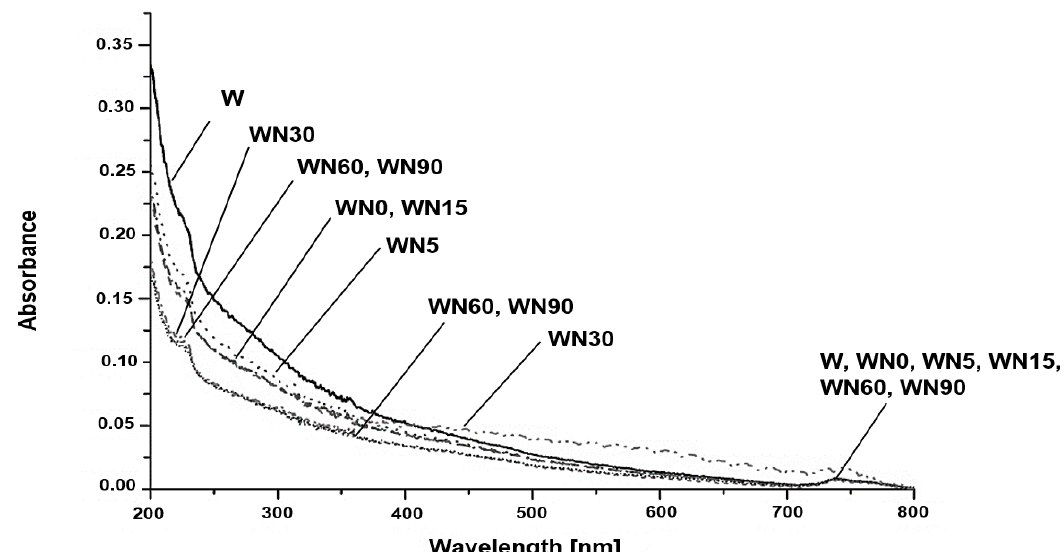
Figure 2. Ultraviolet (UV) absorption spectra of controlled, deionized water maintained in the air (W) and controlled deionized water washed with nitrogen (WN0), and that latter water after the GP treatment for 5 to 90 min (WN5–WN90), respectively. Table1. SelectedphysicochemicalpropertiesofcontrolwatersandwatertreatedwithGPundernitrogen. Water a